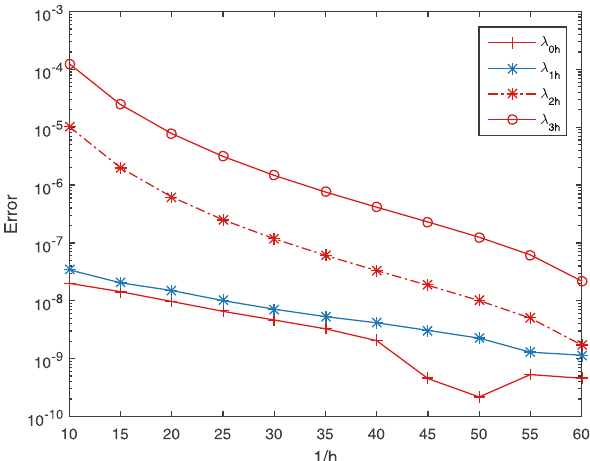
Figure 1: Errors between numerical solutions and the reference solution for = R